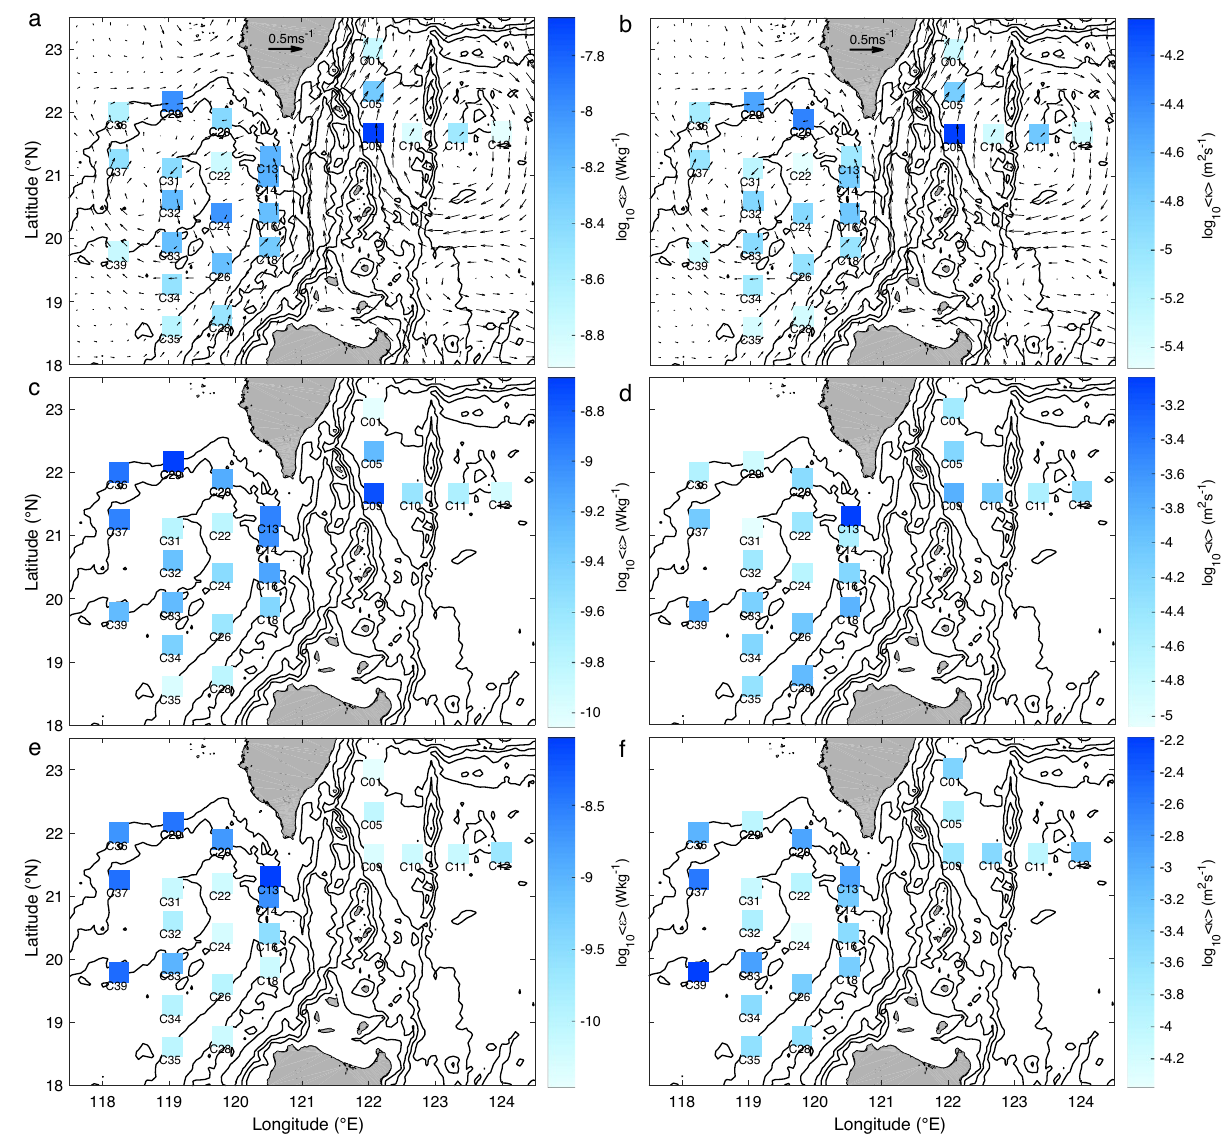
Figure 3. Maps of the layer-averaged dissipation rate (< ε > , left) and diapycnal diffusivity (< κ > , right) for the upper layer ( a , b ), middle layer ( c , d ), and bottom layer ( e , f ). Mean surface geostrophic currents from May 29 to June 24, 2018, are shown in ( a ) and ( b ). Figures were plotted using MATLAB R2016b (http:// www. mathw orks. and bottom layers (within 500 MAB), defined based on depth, are similar to those in Figs. 3 and 4. A dramatic difference in κ is shown in the middle layer (500–1500 m) because the depth in the NSCS is shallower than that in the WP. This results in a comparison of bottom-enhanced turbulence in the NSCS with mild turbulence in the middle layer of the WP, and this comparison is unfair. Discussion